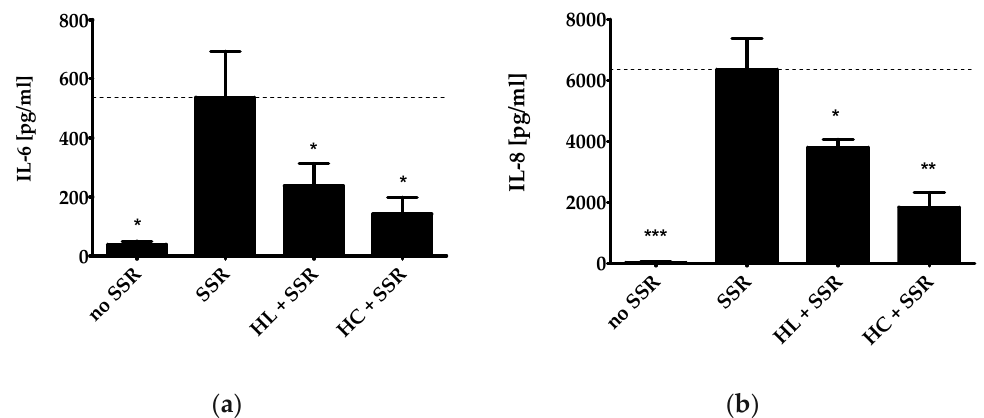
Figure 2. Effect of HL extract on the secretion of IL-6 and IL-8. PHKs were pretreated with HL extract (4 µg/mL) or HC (20 µg/mL) for 2 h and irradiated with 6 J/cm 2 using a solar simulator. The cell culture supernatant was collected after 24 h of non-irradiated PHKs (no solar simulator radiation (SSR)), after irradiation (SSR), with HL extract treatment before SSR (HL + SSR), and HC pretreatment before SSR (HC + SSR). Then, secretion of IL-6 ( a ) and IL-8 ( b ) was measured using ELISA. Results of three independent experiments are shown as mean ± SD. The statistical significances were calculated in relation to the SSR-treated sample; * p ≤ 0.05, ** p ≤ 0.01, *** p ≤ 0.001.